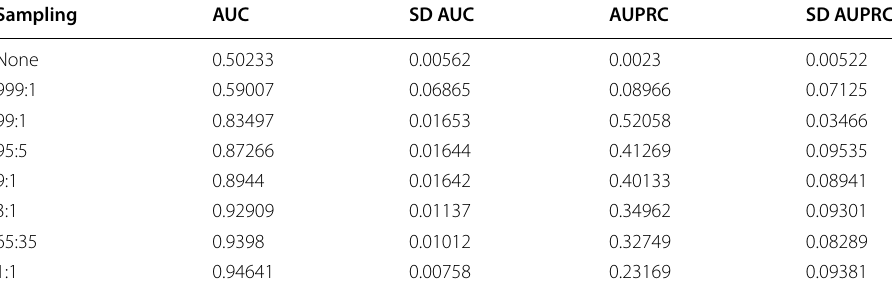
Table 14 Results for LightGBM